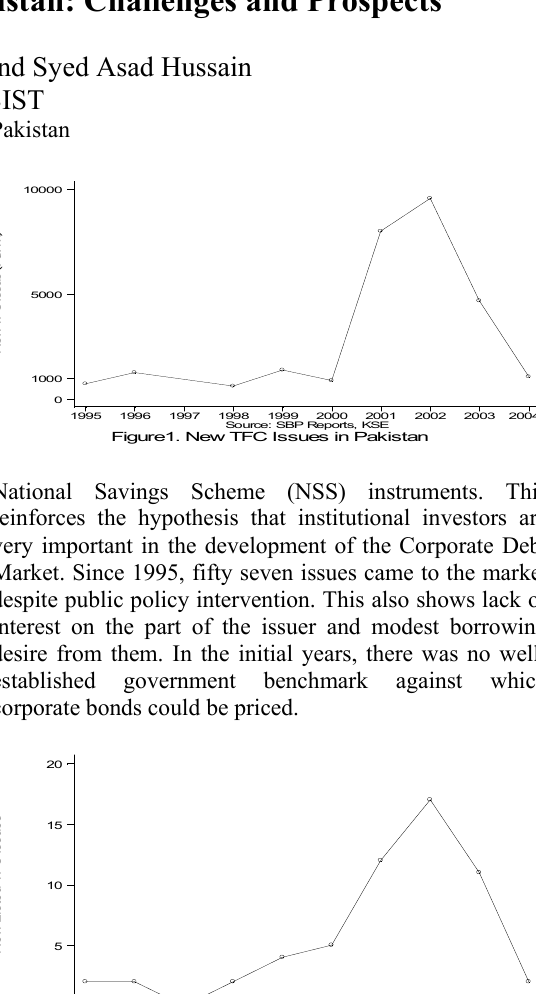
SECP1995 1996 1997 1998 1999 2000 2001 2002 Source: SBP Reports, KSE, Figure 2. New TFC Issues in Pakistan